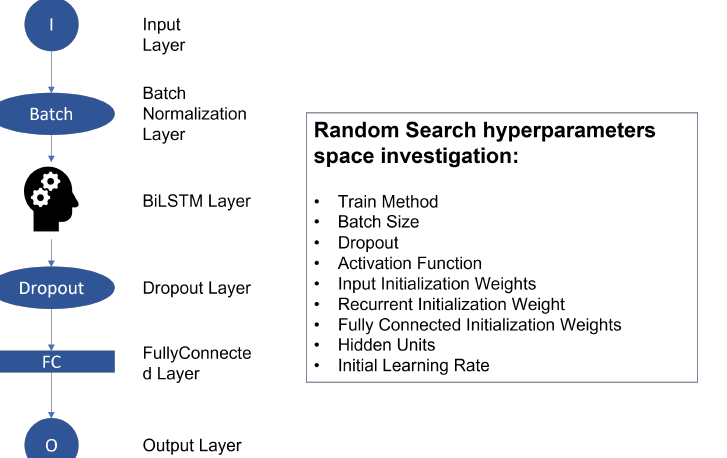
Figure 3. AI model graph based on Bi-LSTM network and hyperparameters investigated by the random-search optimization technique. The input layer normalizes data with the z-score method. A batch normalization layer normalizes a batch of data across all observations. The Bi-LSTM layer is defined by the number of hidden units (hidden state, correspondent to the number of information remembered between time steps), the activation function to update the cell and hidden state, and the weights initialization. The dropout layer randomly drops out input elements. The fully connected layer performs output of one dimension. The output layer computes the half-mean-squared-error loss for the regression task